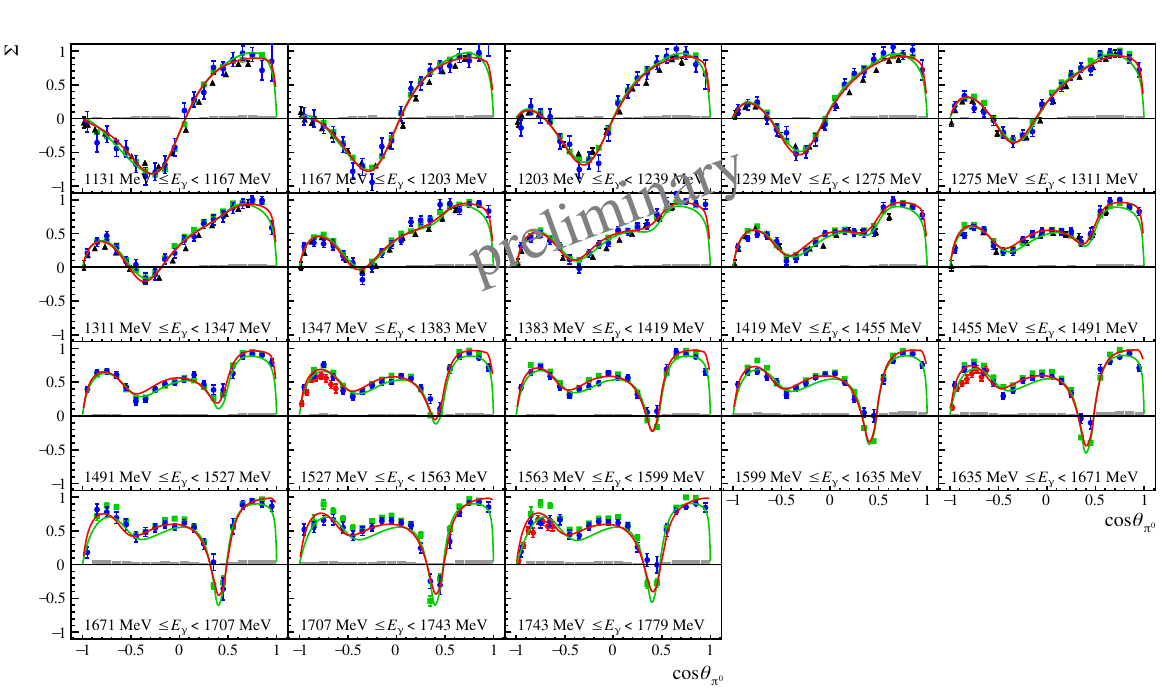
Figure 3. The preliminary results for the beam asymmetry Σ (blue points) are shown as a function of cos θ π 0 for a beam photon energy range from E γ = 1131 MeV to E γ = 1779 MeV for the p π 0 final state. The data are compared to data from the CLAS collaboration (green squares) [5], from the GRAAL collaboration (black triangles) [39] and from the LEPS collaboration (red points) [7]. In addition the data are compared to the latest PWA solutions of BnGa [40] and JüBo-2017 [16]. The systematic error is represented by the gray area.